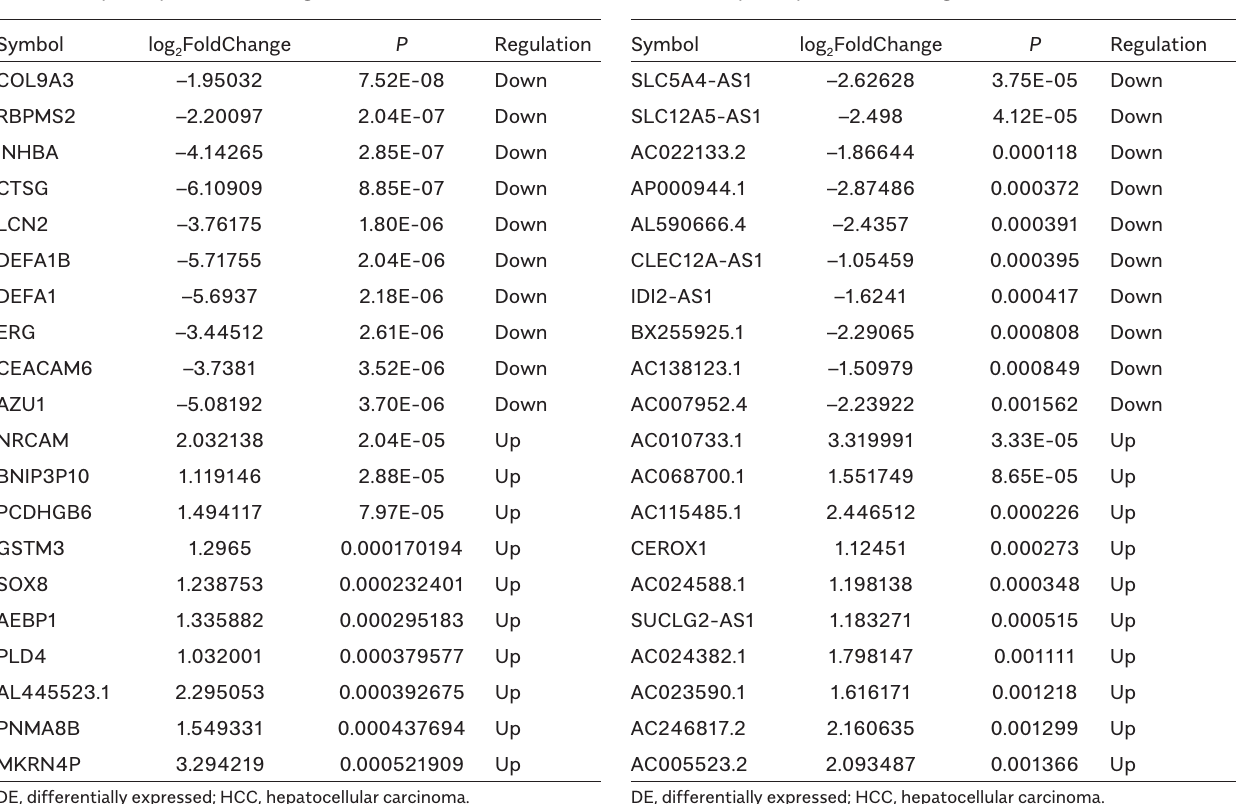
Table 2. Top 10 Up- and Down Regulated DElncRNAs in